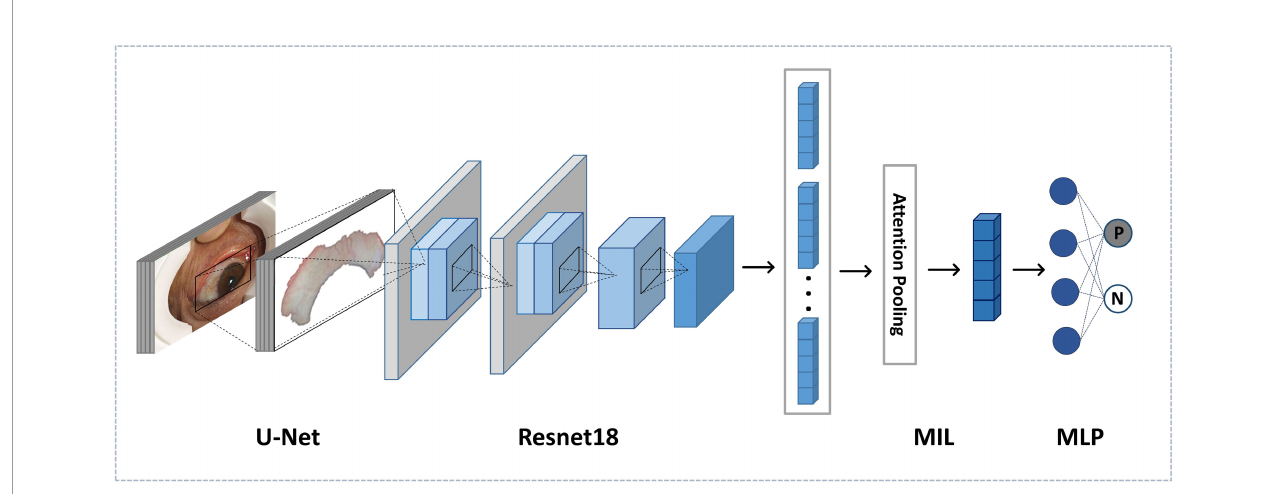
FIGURE 3 | Overview of the framework of the diagnosis